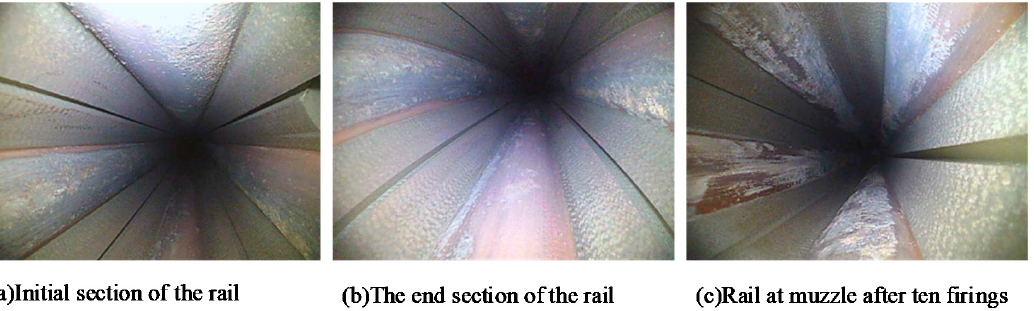
Figure 18. Rail after launch. ( a ) Initial section of the rail (armature displacement less than 50 mm). ( b ) The end section of the rail (the distance to the muzzle is less than 50 mm). ( c ) Rail at the muzzle after ten firings (the distance to the muzzle is less than 50 mm).